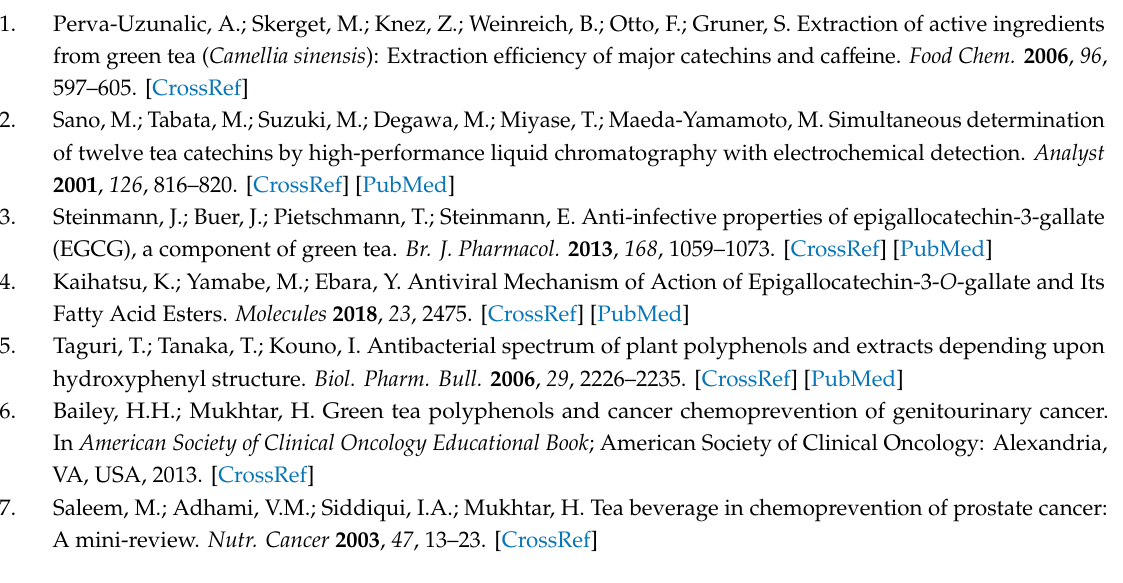
Figure S1: GTE reduced VAT and decreased plasma TG and TCHO levels in an adult zebrafish independent replicate experiment, Table S1: Protein expression targets regulated by GTE in GTE-treated OF zebrafish compared with those of OF zebrafish, Table S2: Gene expression ratios in WNT / β -catenin signaling pathway in GTE-treated OF zebrafish compared to those in OF control zebrafish, Table S3: Gene expression ratios in AMPK signaling pathway in GTE-treated OF zebrafish compared to those in OF control zebrafish, Table S4: Details of feeding zebrafish; Table S5: Primer pair sequences, accession numbers and product sizes of the studied